Question: What form of chart is displayed?
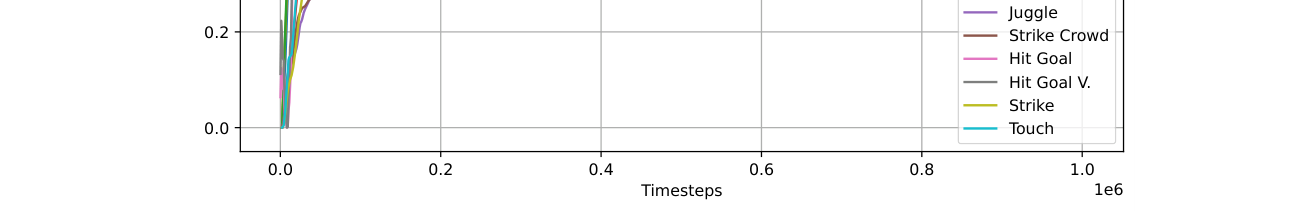
Answer: line